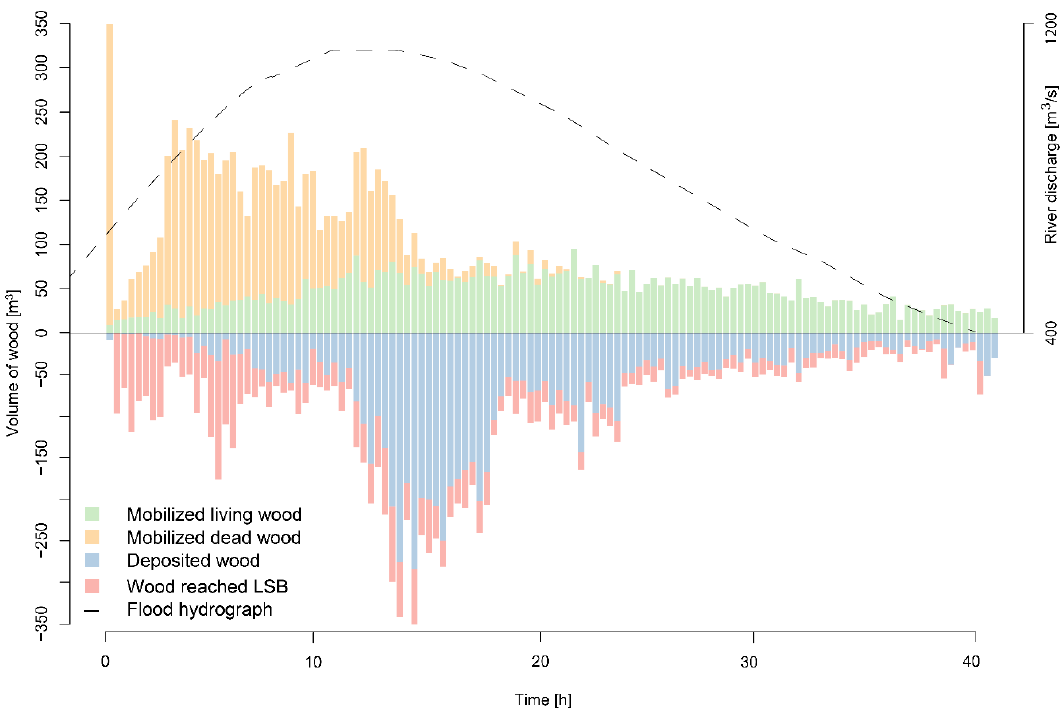
Figure 4. Simulated temporal distribution of LW dynamics in a worst case flood along the Aare River.